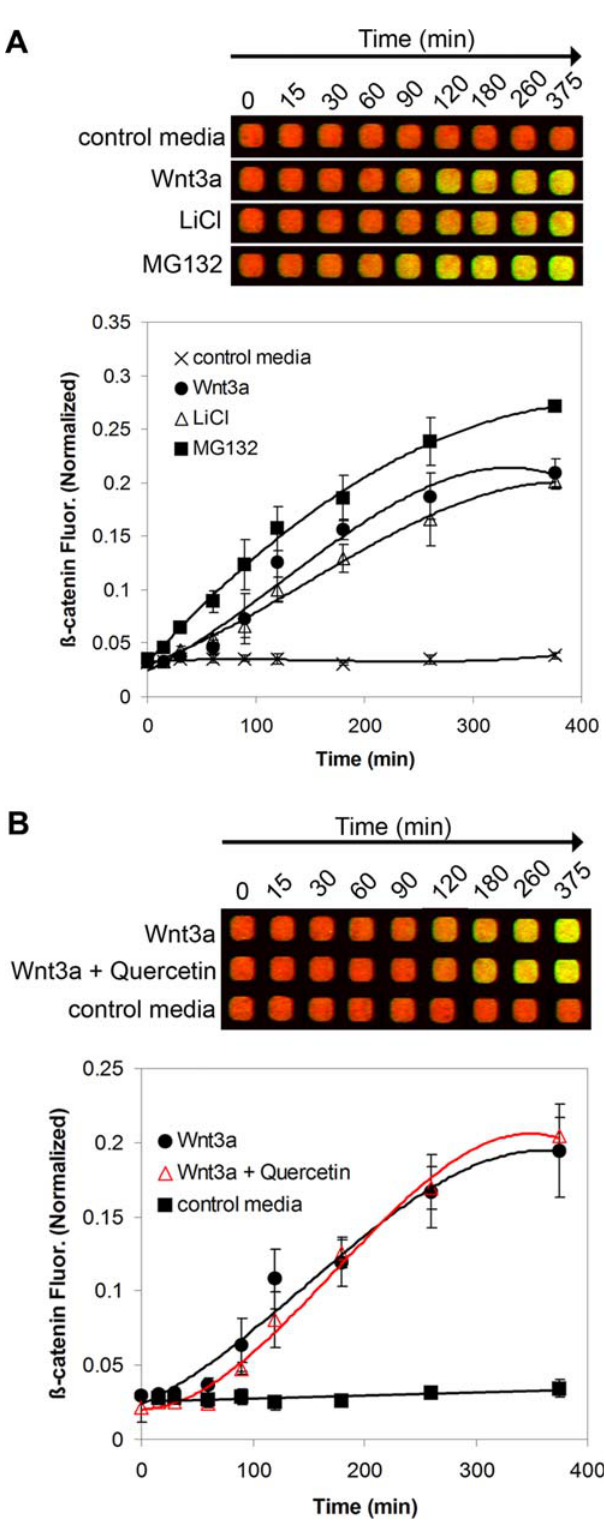
Figure 2. Monitoring cellular b -catenin accumulation in re- sponse to various stimuli. (A) L-cells were treated with either Wnt3a (50 ng/ml), LiCl (50 mM) or MG132 (25 m M) for the indicated periods of time and processed for imaging as described in methods. (B) Monitoring the effects of a pharmacologic inhibitor of Wnt signaling on b -catenin accumulation. L-cells were treated with Wnt3a (50 ng/ml) in the absence or presence of 100 m M quercetin for the indicated times. Each point represents mean 6 SEM (n=3–4).